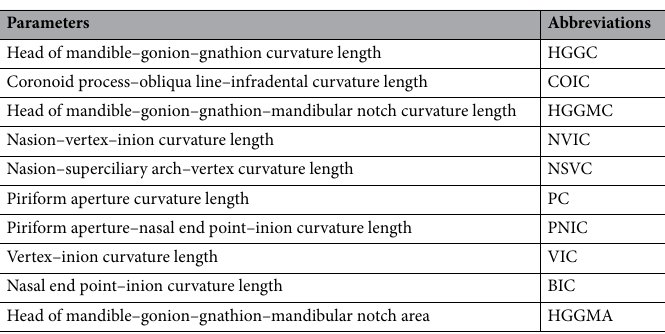
Table 7. Curve lenght-area parameters and abbreviations.